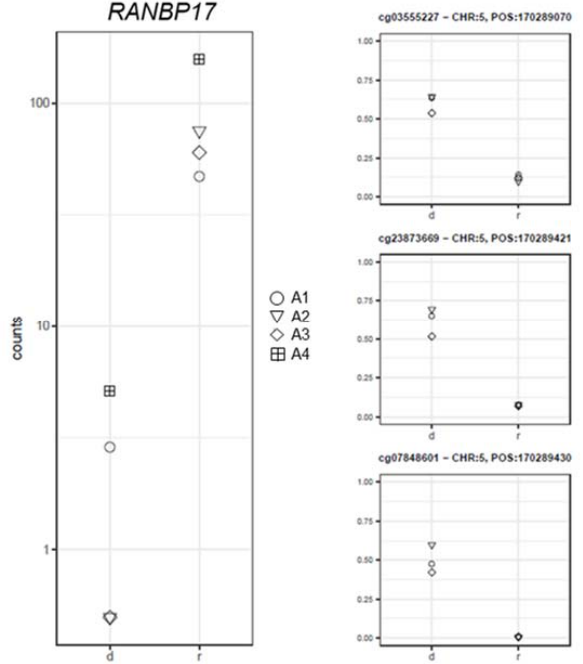
Figure 7. Gene expression (left panel) and corresponding methylation level (right panel) comparison between the samples at diagnosis (d) and remission (r) for the RANBP17 gene. Conversely, the MACROD2 expression levels decreased at remission and showed a positive association with the methylation levels of nine CpGs (log2FC = 5.83; PFDR = 3.18 × 10 − 9 ; 0.86 ≤ rho ≤ 0.99; Pcorr ≤ 0.03; Figure 8).